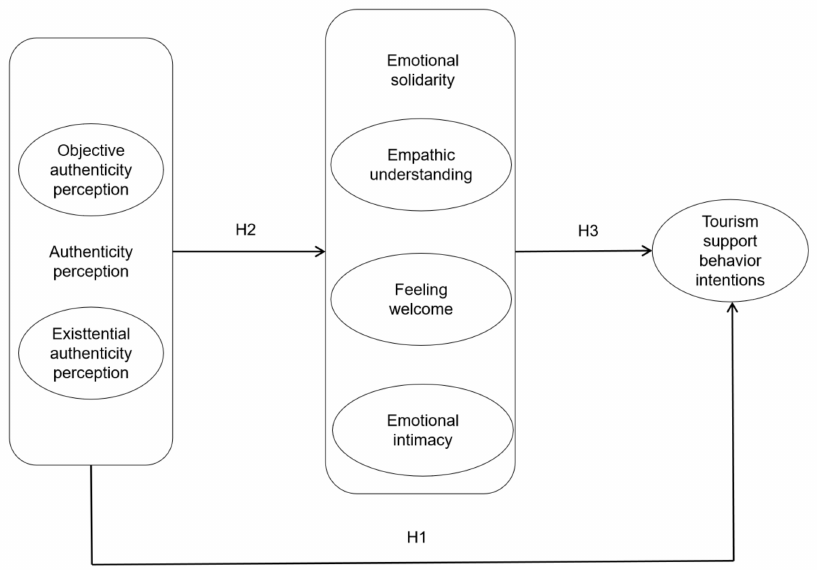
Figure 1. Research